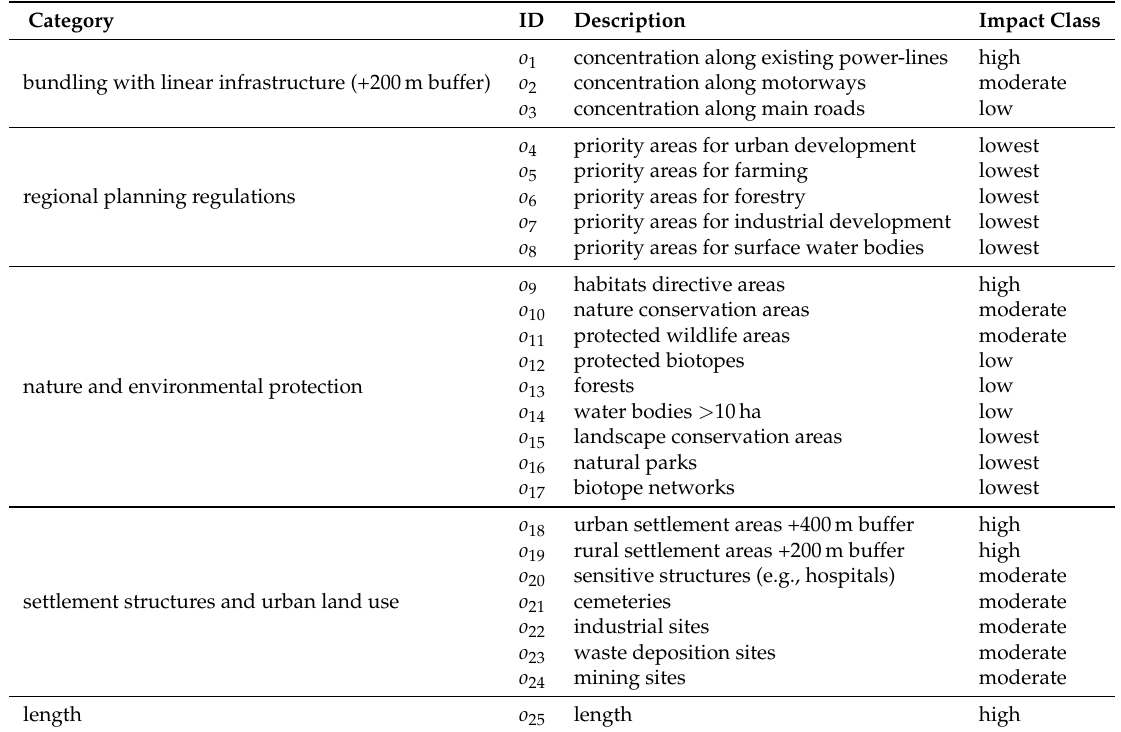
Table 1. Evaluated criteria for finding optimised transmission line routes and their impact